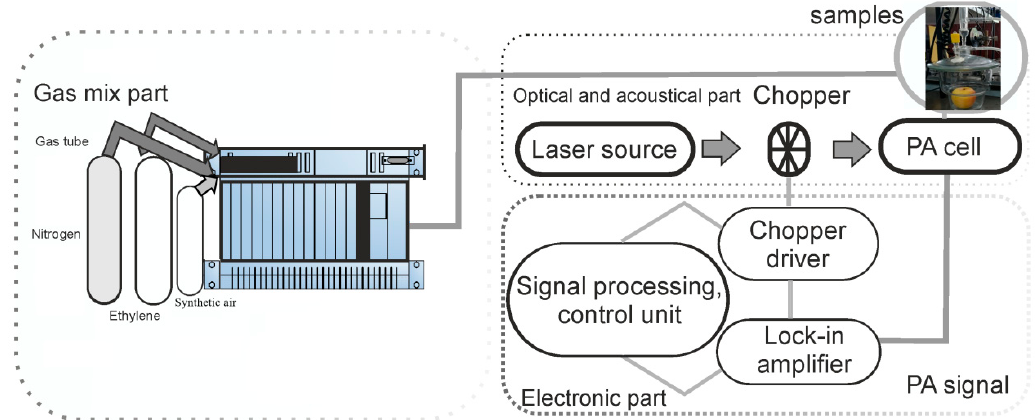
Figure 1. Block diagram of the CO 2 laser photoacoustic system.